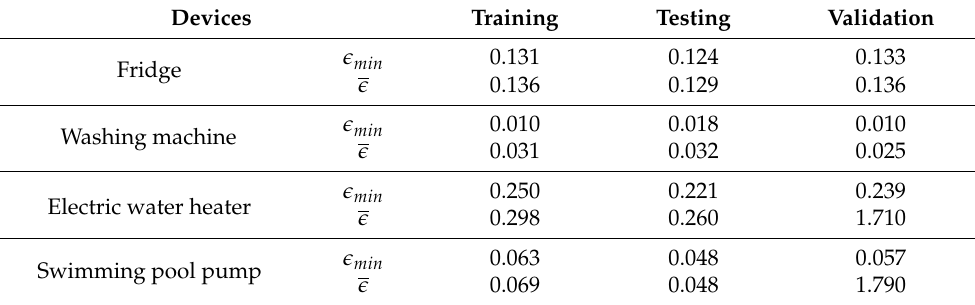
Table 6. Estimation performance in the non-dominated sets.